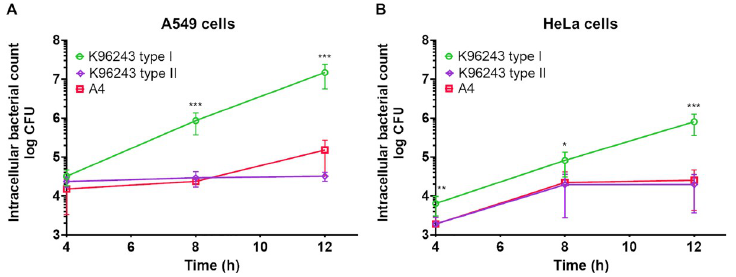
Fig 1. B . pseudomallei strains K96243 type II and A4 are defective in intracellular replication in A549 and HeLa cells. K96243 type I and plaque-forming-defective strains K96243 type II and A4 were used to infect A549 cells (A) at a multiplicity of infection (MOI) of 5 or HeLa cells (B) at MOI of 10. Number intracellular bacteria at 4-, 8- and 12-h post infection was determined. The assays were performed in triplicate in two independent experiments. The number of bacteria was counted by drop plate technique and the data represent means ± standard deviation. � P � 0.01; �� P � 0.005; ��� P �